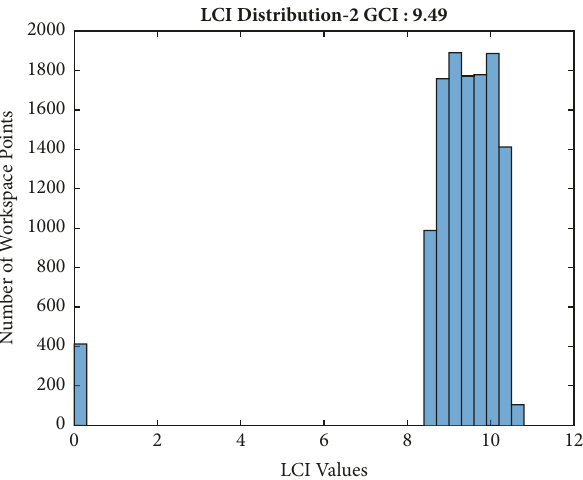
Figure 10: Distribution of LCI values based on un/reachable workspace points for three-parameter optimization, 𝑟 𝑏,𝑜𝑝𝑡 = 0.127[m], 𝑟 𝑝,𝑜𝑝𝑡 = 0.072[m], and 𝑙 𝑖 = 0.300-0.450[m].